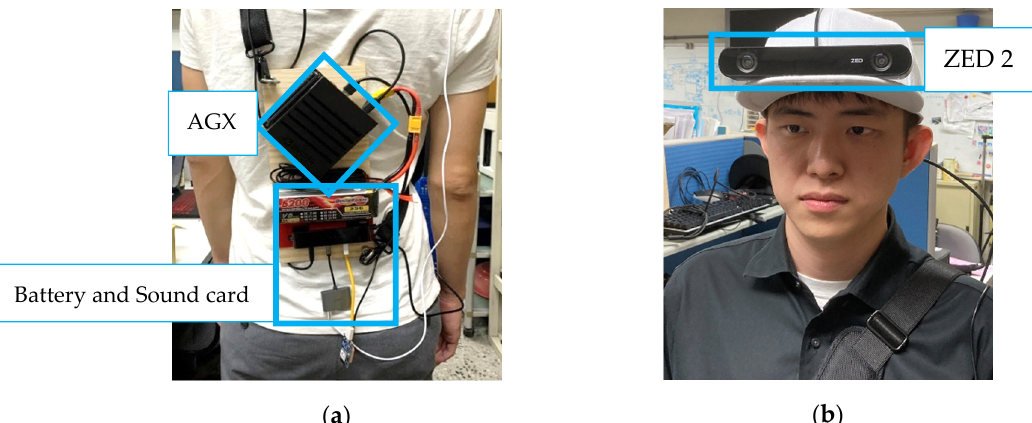
Figure 1. The hardware of the whole assistive system, ( a ) AGX, battery, and sound card on the backboard; ( b ) The ZED 2 on the cap.